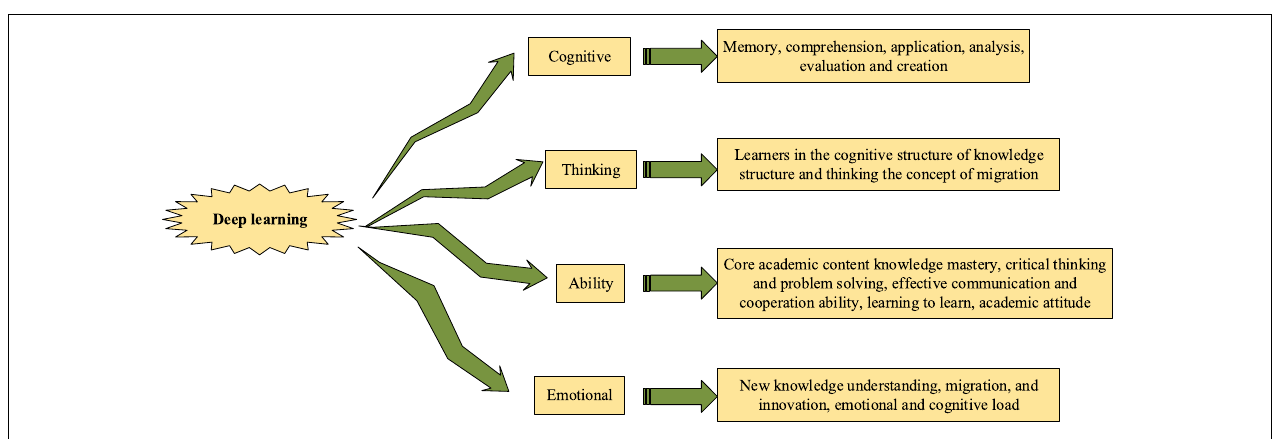
FIGURE 2 | Different definitions of deep